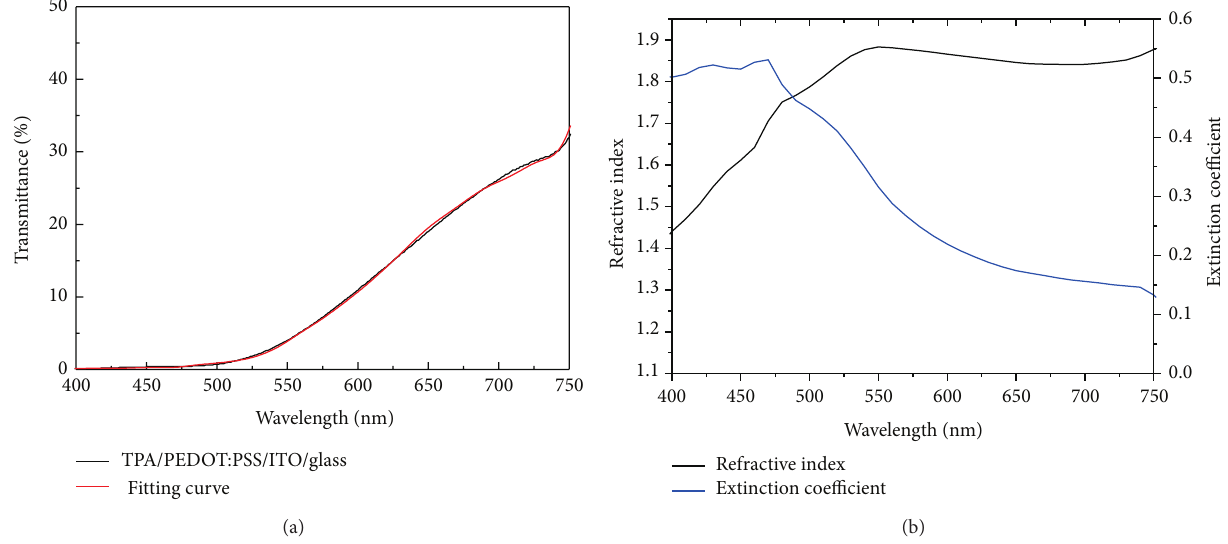
Figure 1: (a) Transmittance spectra of TPA/PEDOT:PSS/ITO/glass under normal incidence. (b) Refractive index and extinction coefficient of TPA film.